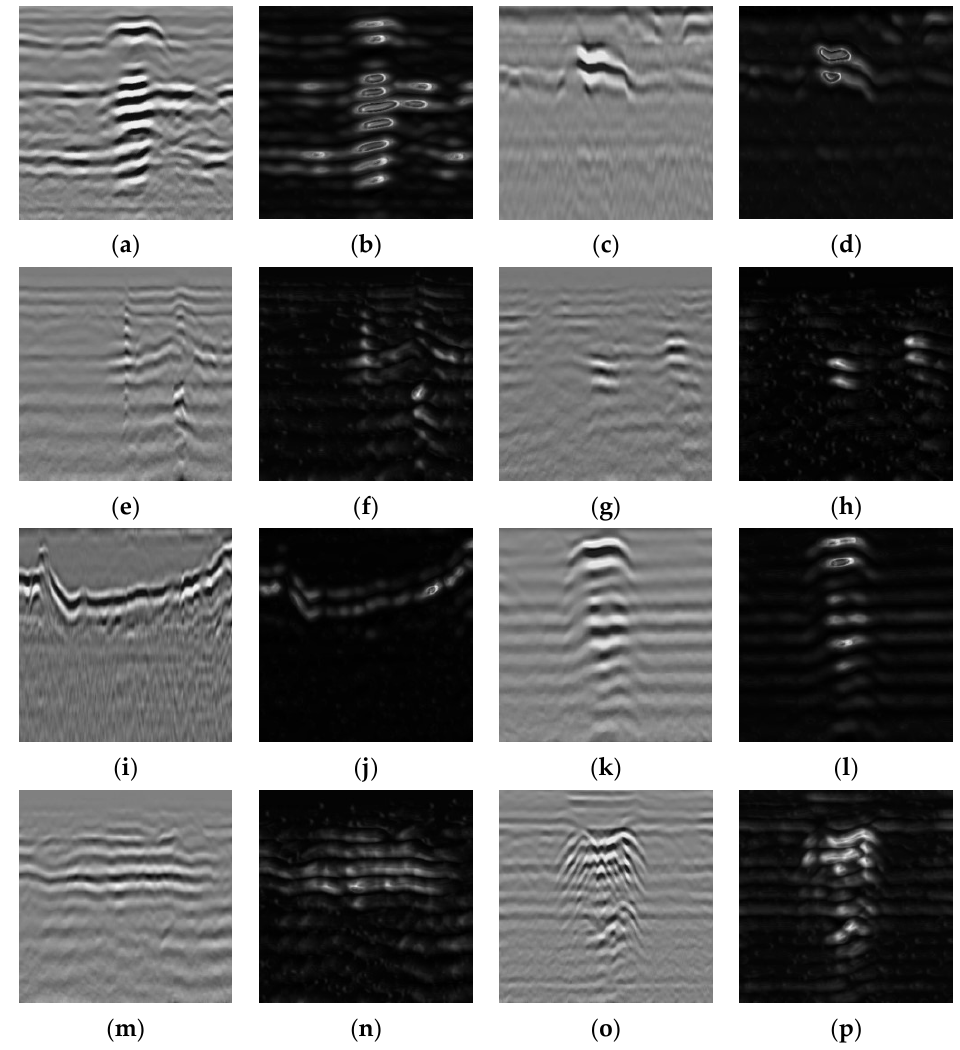
Figure 11. Abnormal significance region: ( a , c , e , g , i , k , m , o ) are the filtered GPR image 1 to filtered GPR image 8; ( b , d , f , h , j , l , n , p ) are the abnormally significant region.